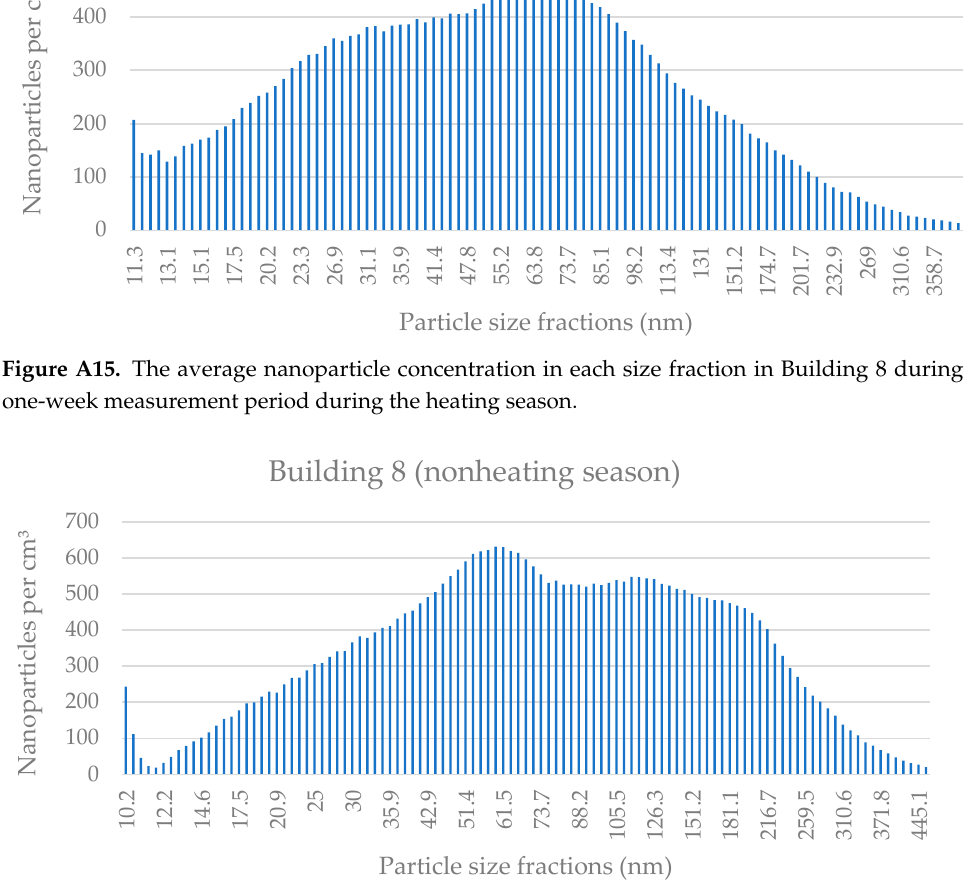
Figure A16. The average nanoparticle concentration in each size fraction in Building 8 during a one-week measurement period during the nonheating season.